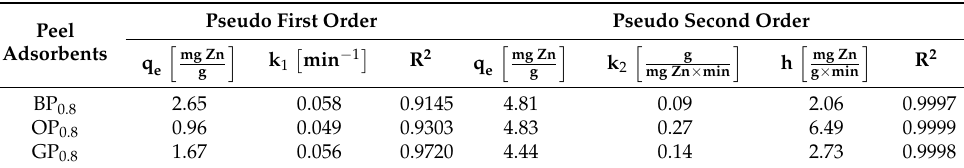
Table 3. Kinetics parameters for Zn(II) ions removal using the chemically modified BP 0.8 , GP 0.8 , and OP 0.8